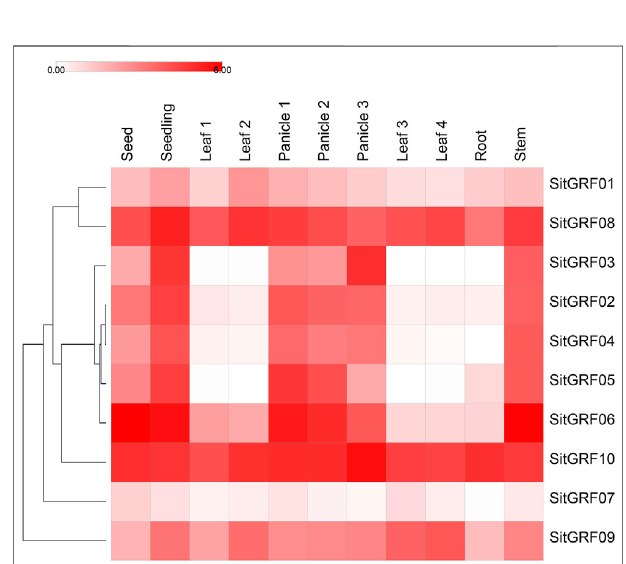
FIGURE 9| Expression offoxtail millet GRF genes in the different organs andperiods.Theshadeofthecolorcorrespondstotheexpressionvalue(log2 (TPM+1)). Seed represents 3 days imbibed seeds; seedling represents 2- week-old whole seedling. Leaf 1 represents the top fi rst fully extended leafofa2-week-oldseedling.Leaf2representsthetopsecondleafof30-day- old plants. Panicle 1 represents an immature panicle. Panicle 2 represents a panicle at the pollination stage. Panicle 3 represents a panicleat at the grain- fi llingstage.Leaf3representsa fl agleaf.Leaf4representsthefourthleaf.Root represents the root. Stem represents the